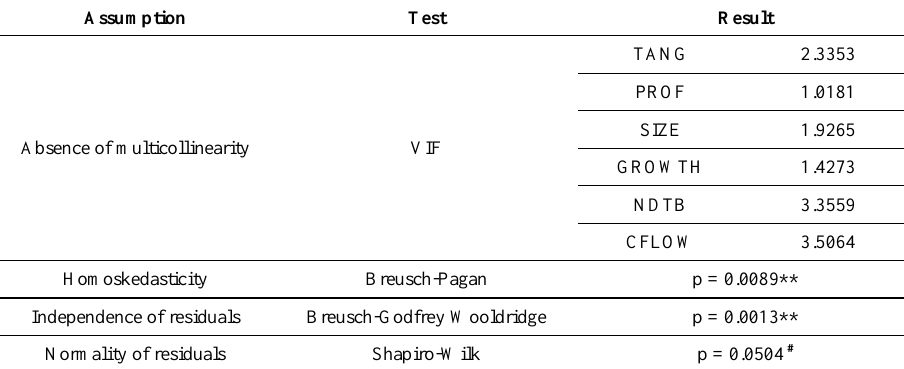
Table 9. Tests of model assumptions.